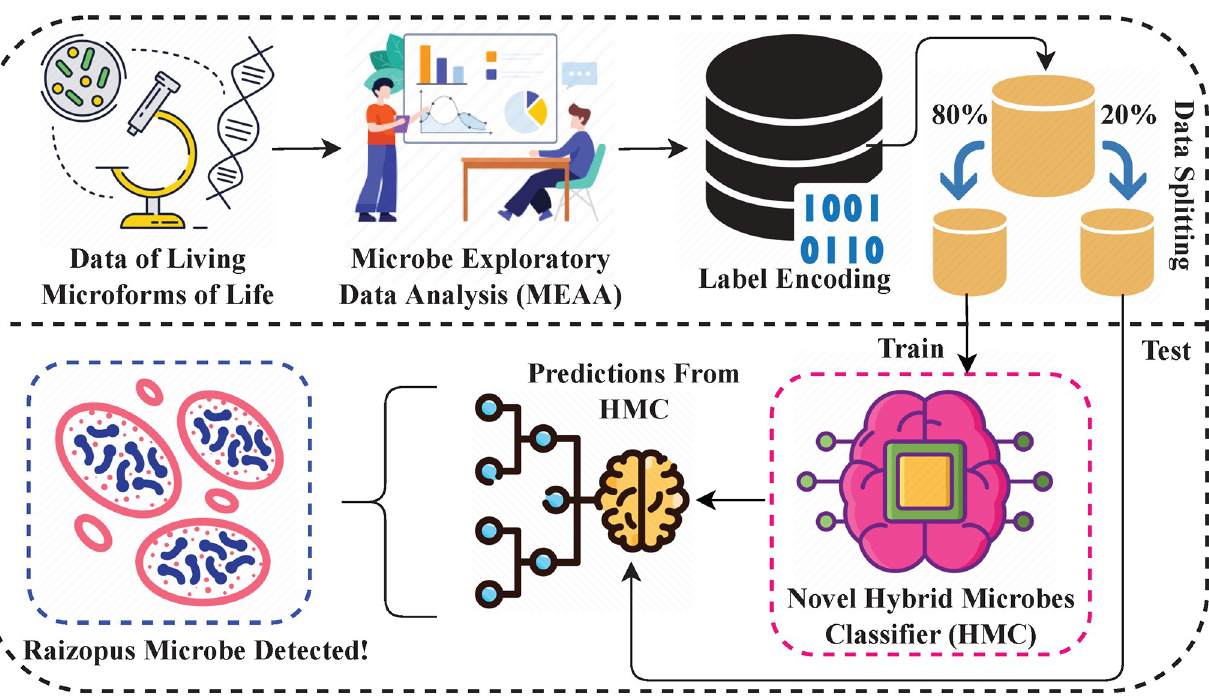
Fig 1. The architecture of the proposed approach for predicting microbe organisms. It involves data collection, exploratory data analysis, model training and testing.